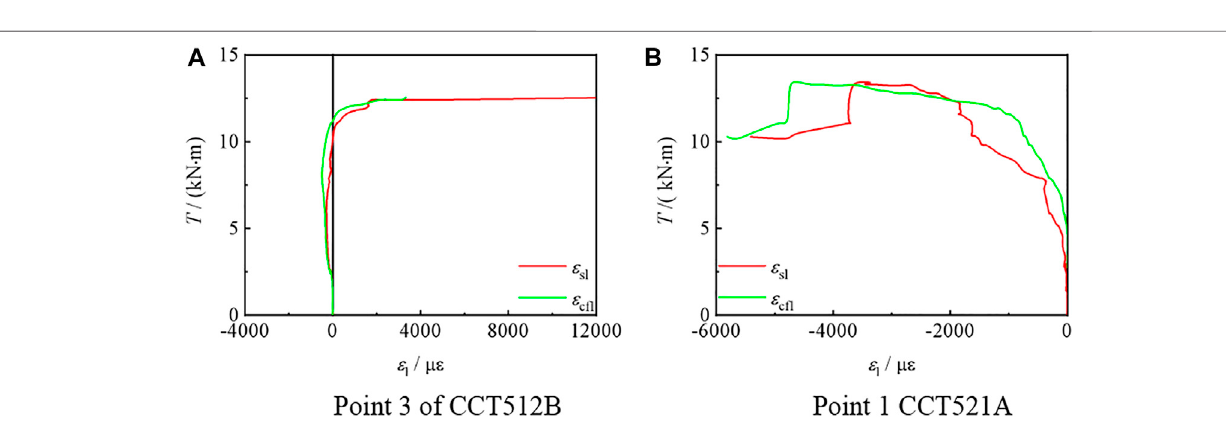
FIGURE 9 | T – ε l curve of the partial C-CF-CFRP-ST specimen. (A) Longitudinal strain of steel tube and (B) CFRP.